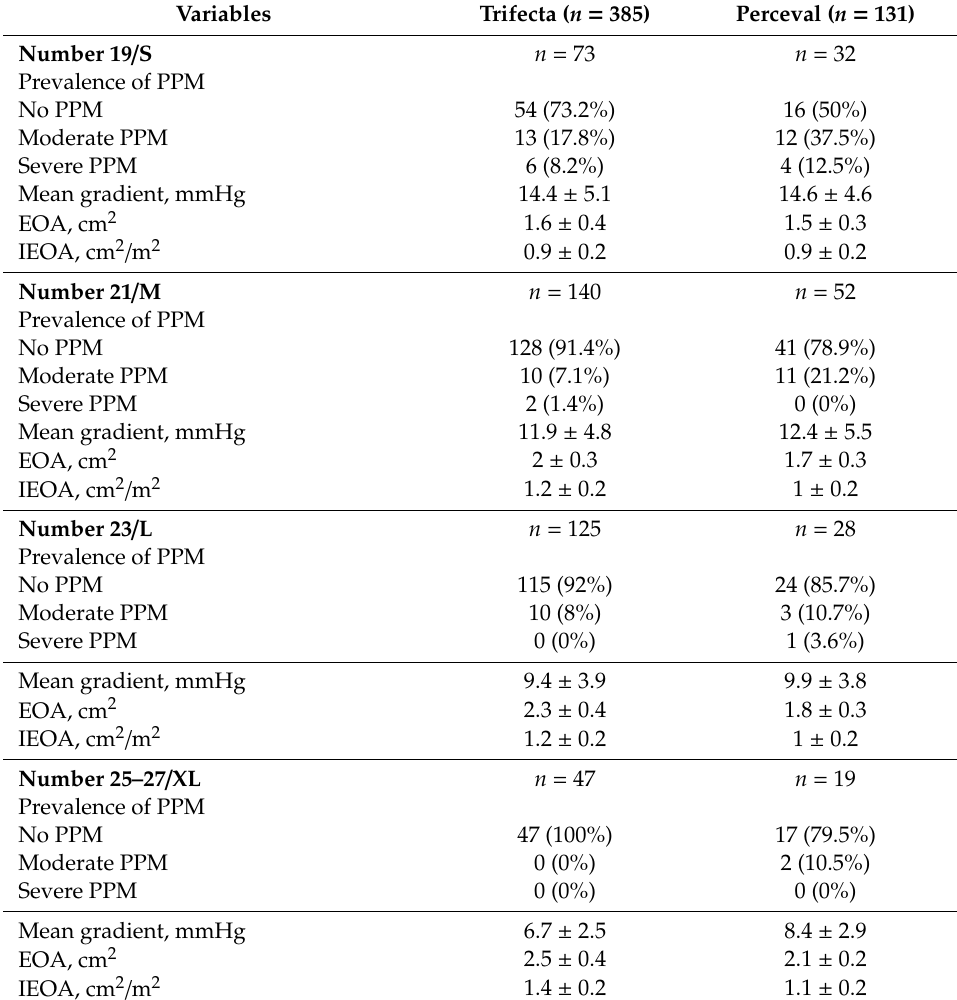
Table 3. Prevalence of PPM and other parameters for patients at